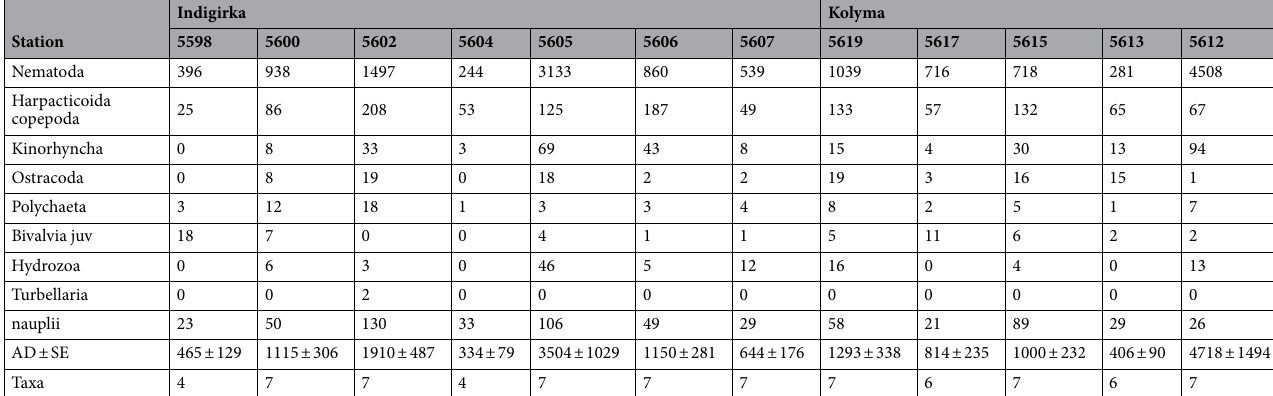
Table 1. Mean average density (AD ± SE ind./10 cm 2 ) of each meiobenthic group in the 0- to 5-cm deep